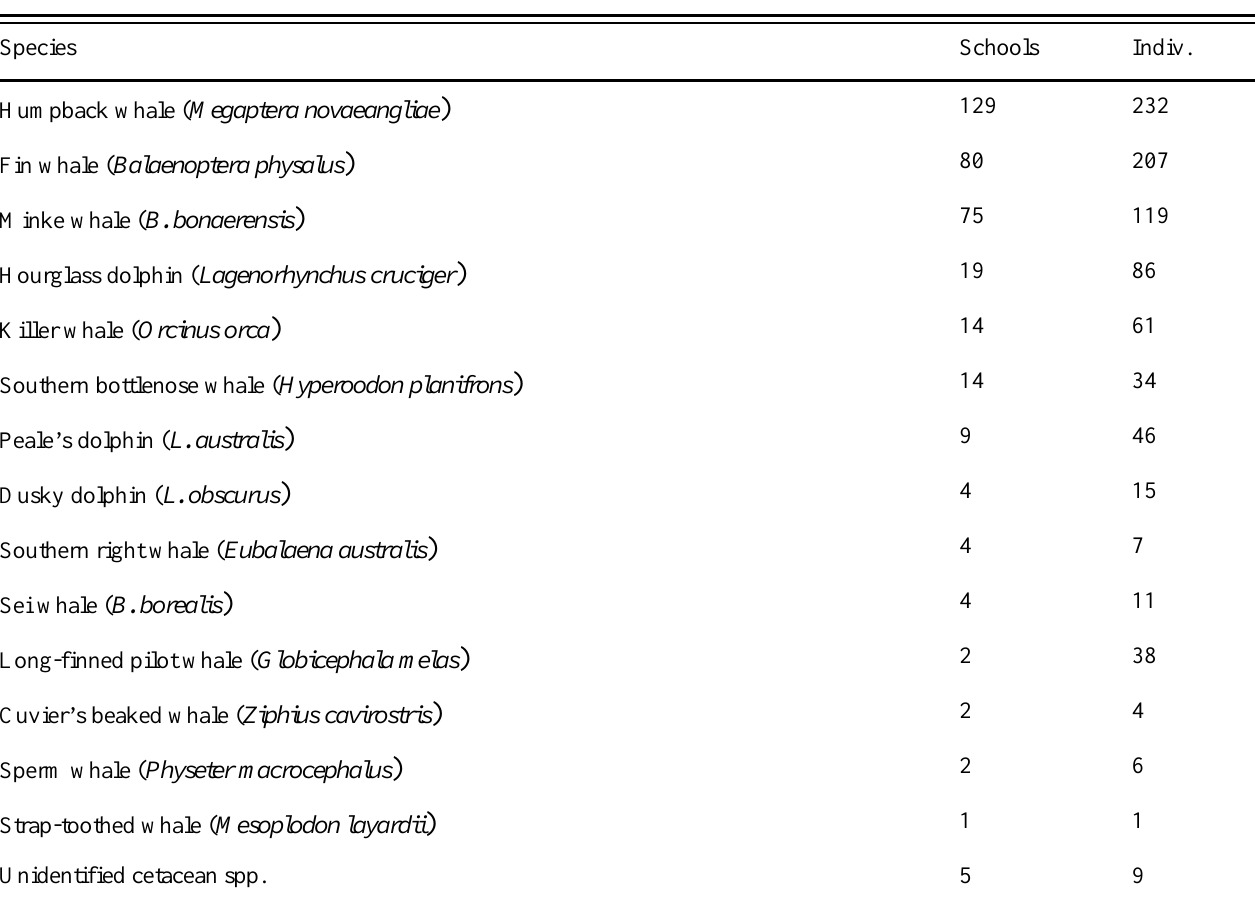
Table 3. Sightings of cetacean schools by species. Species Schools Indiv. Humpback whale ( Megaptera novaeangliae ) Fin whale ( Balaenoptera physalus ) Minke whale ( B. bonaerensis ) Hourglass dolphin ( Lagenorhynchus cruciger